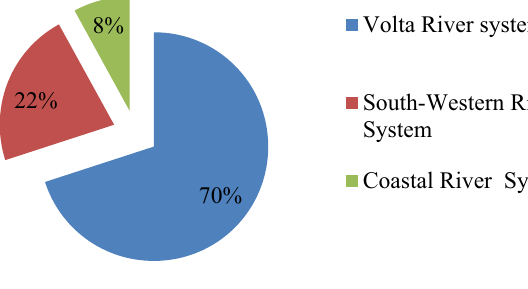
Fig. 1 Surface water resources distribution in